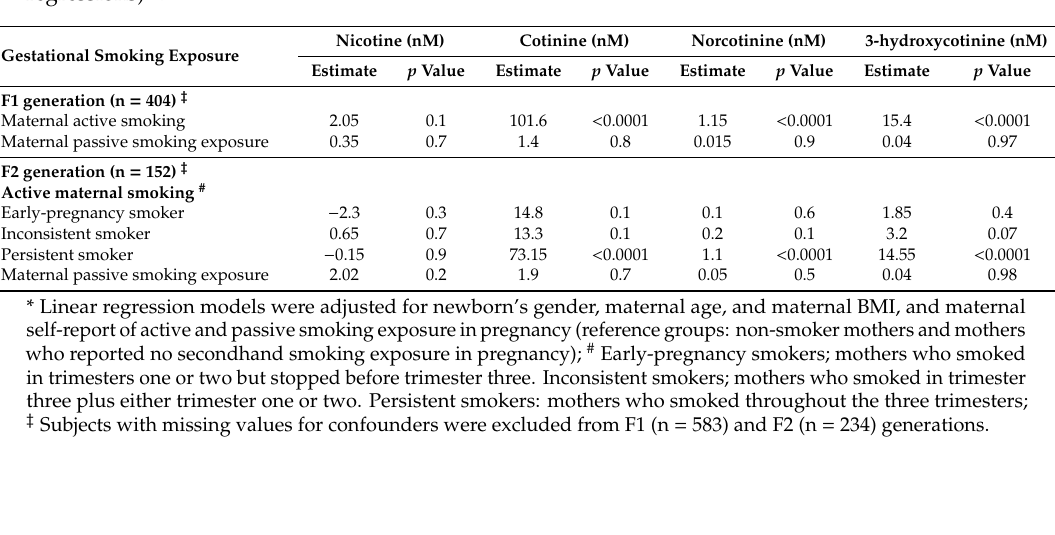
Table 5. Association of nicotine and its metabolites in maternal (F0 mothers of F1) and cord (F2) sera with gestational active smoking and passive smoke exposure (coe ffi cients derived from linear regressions)